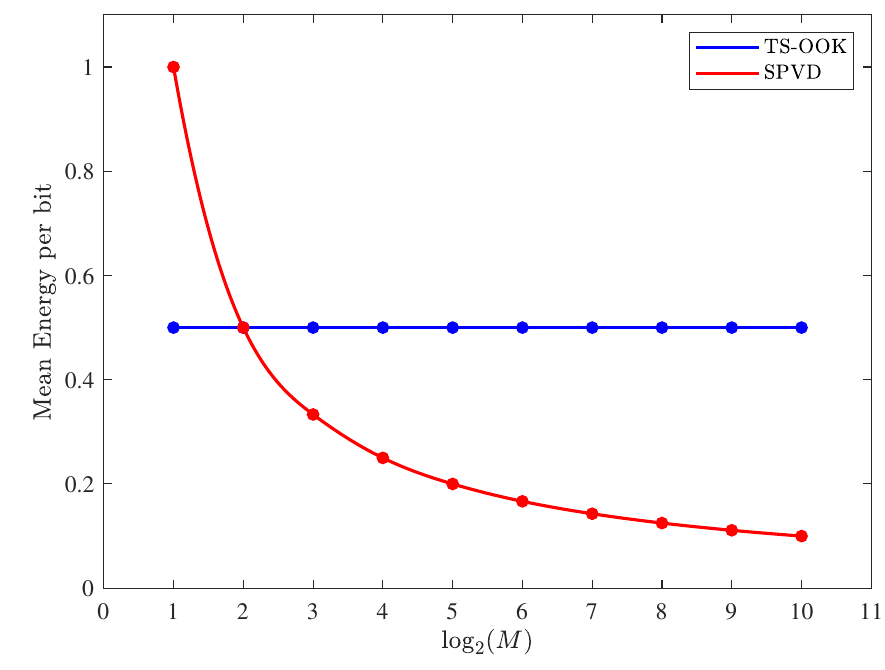
Figure 3. Average Energy